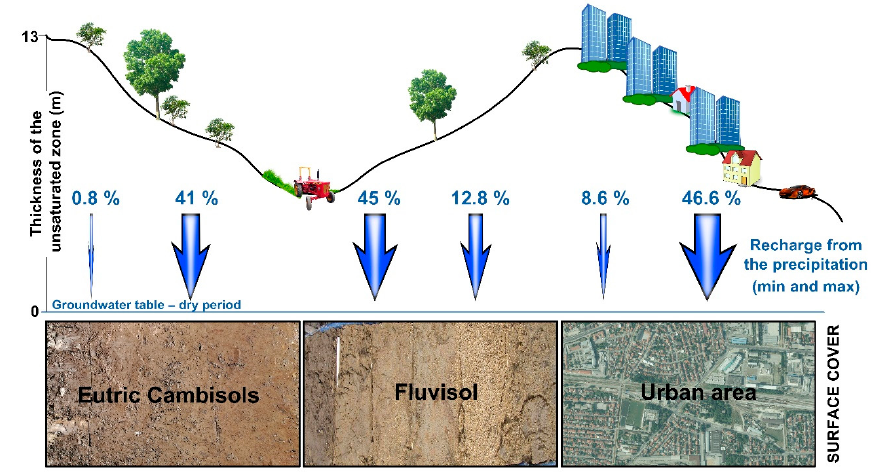
Figure 7. The conceptual illustration of groundwater recharge of the Zagreb aquifer system through the unsaturated zone with different thickness and surface covers in two-component mixing model.